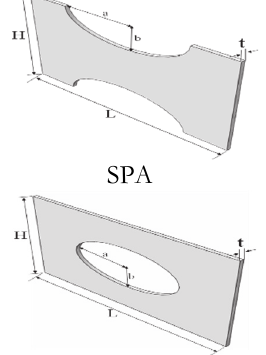
Figure 1: Coupling beam damper with top and bottom